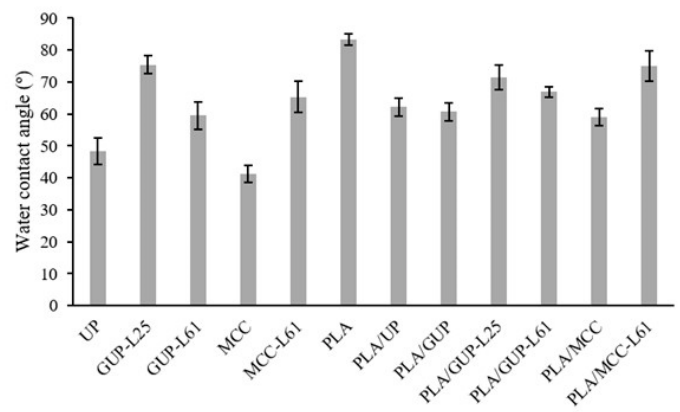
Figure 8. Water contact angle of cellulose samples, PLA and PLA/cellulose biocomposite spheres (see Table 1 for abbreviations).